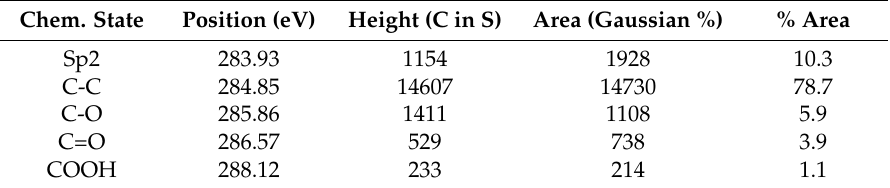
Figure 4. X-ray photoelectron spectroscopy (XPS) data of the oxidized diamond surface following VUV irradiation for 45 min. The insert shows the wide graph for the carboxyl coverage. Table 1. Core-level C 1s binding energies of various types of chemical groups on the diamond surface after VUV irradiation for 45 min.